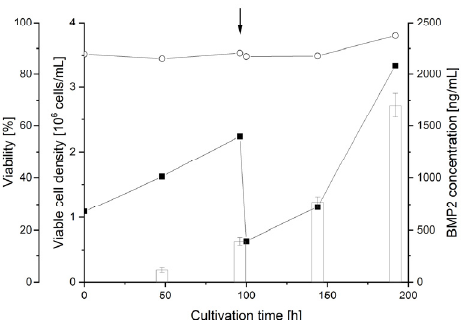
Figure 5. RTT from medium to large scale performed with the plasmid pchBMP2 spiked with 1% ( w/w ) pEGFP-N1 (n = 1). Shown are the viable cell density ( ■ ) and viability ( ○ ). The BMP2 concentration is shown as bars. Arrows indicate the time point of repeated transient transfection.